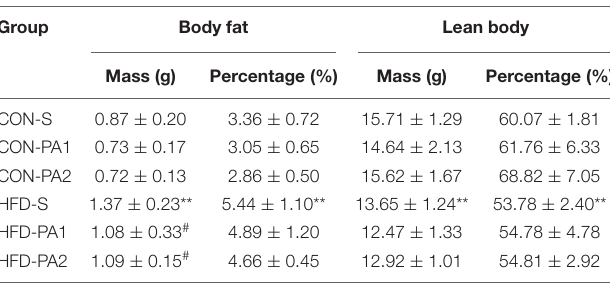
TABLE 2 | Comparison of body composition at